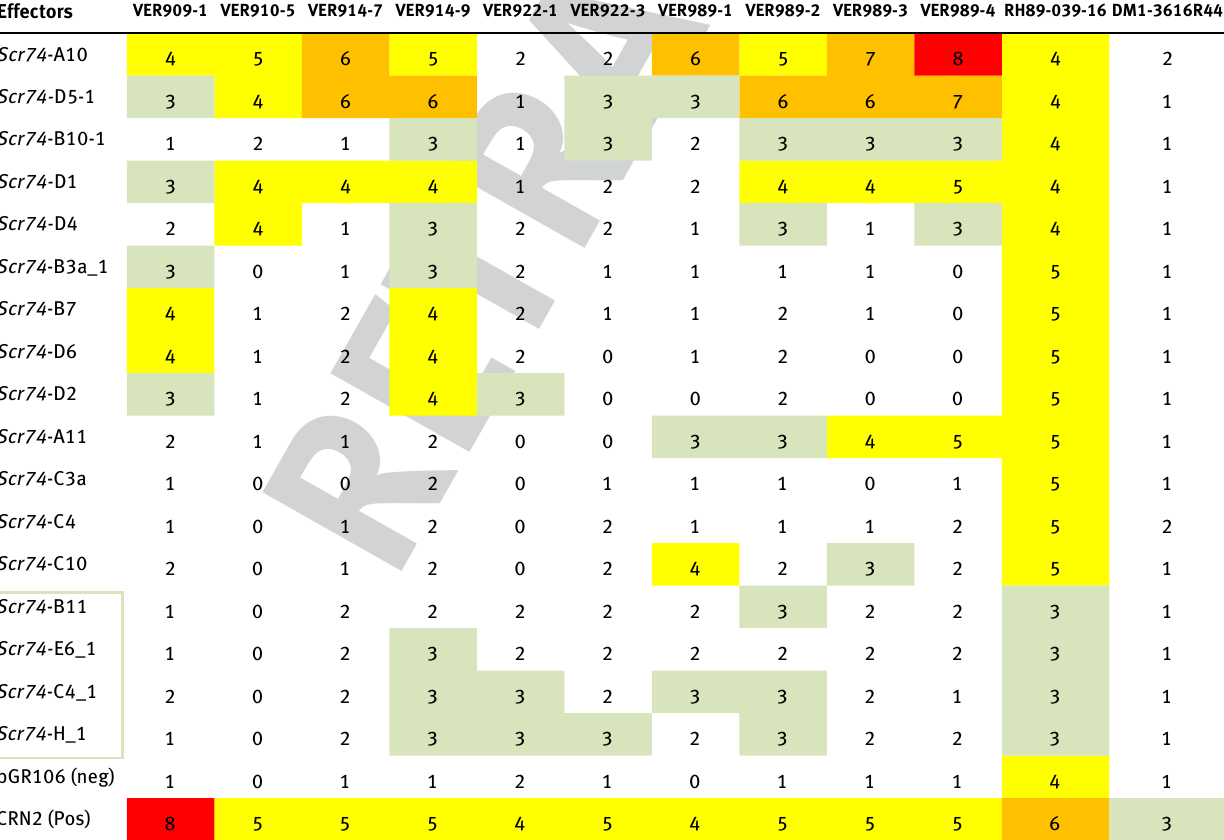
Table 6 . Response matrix of cell death index for 12 P. isolates on 12 wild potato